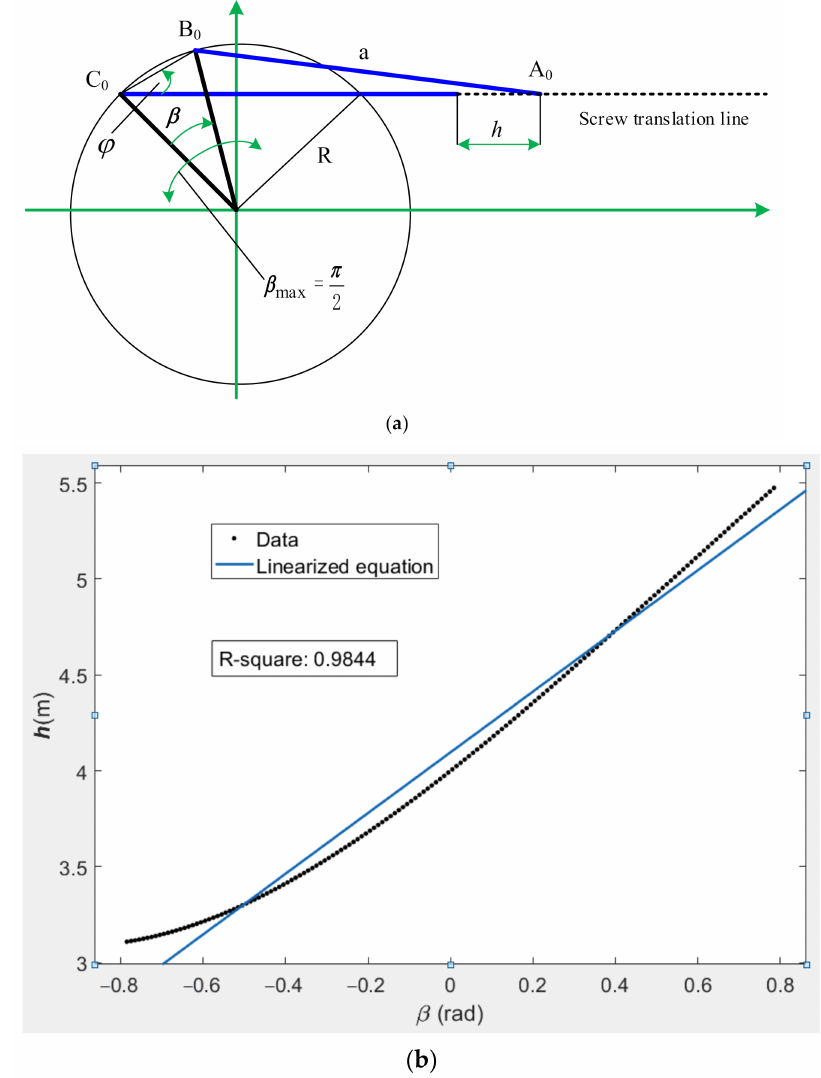
Figure A1. The deduction of the mathematical relationship between pitch angle β and slider dis- placement h . ( a ) The angles of geometry of slider-linkage mechanism motions according to the actual design in the present study; ( b ) Schematic illustration of the linearization process based on raw data of h ∼ β